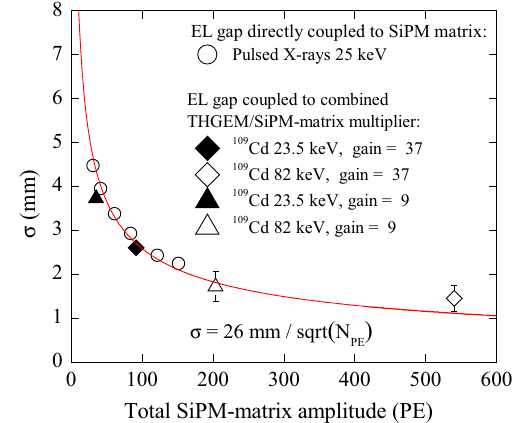
Fig. 22 Summary of position resolution results obtained in the two- phase detector for the direct SiPM-matrix and THGEM/SiPM-matrix readout. Shown is the position resolution (standard deviation) as a func- tion of the total number of photoelectrons recorded by the SiPM matrix. Red curve is the fit by inverse root function using all data